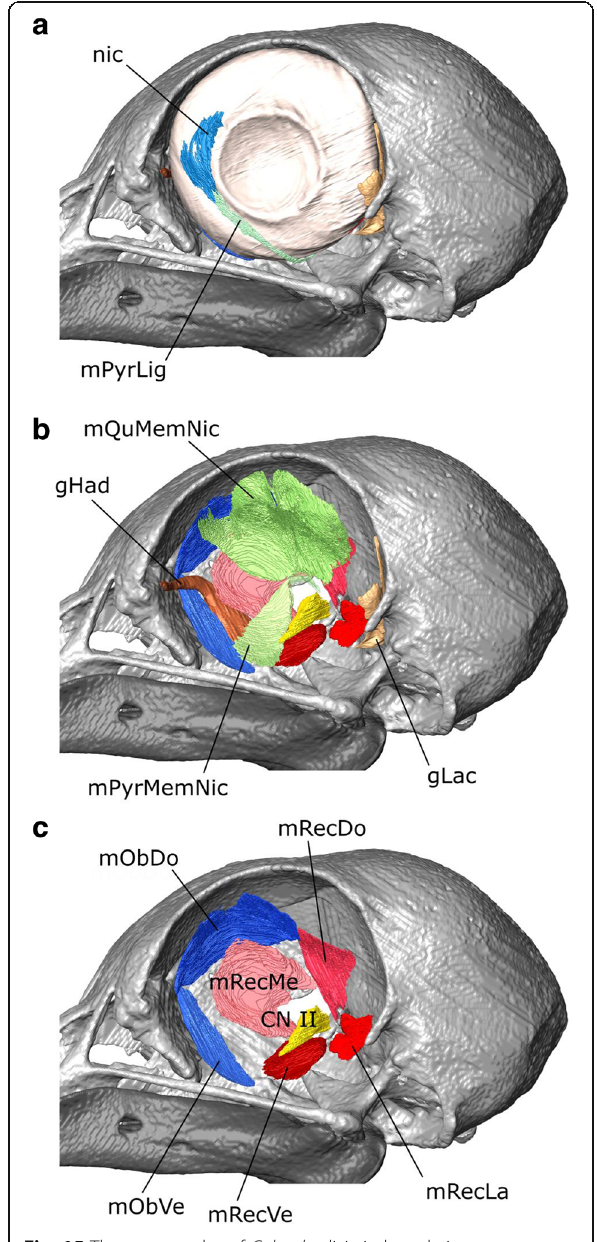
Fig. 15 The eye muscles of Columba livia in lateral view. a to c represent increasingly deep dissections. a the nictitating membrane and associated ligament, b the intrinsic and extrinsic muscles, c the extrinsic muscles